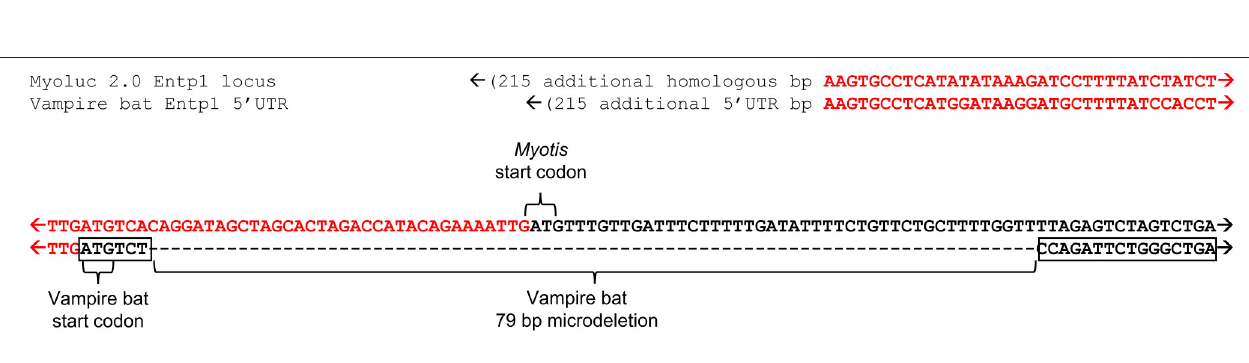
FIGURE 1 | Exon mapping of recruited vampire bat secretory genes to orthologous genomic regions. Vampire bat exons encoding secretory signal peptide sequences are indicated in red. Exon 1 of vampire bat long Lrp1 isoform did not map, and uncertainty on this exon’s position is indicated by the absence of intron 1 designation (see text for details).